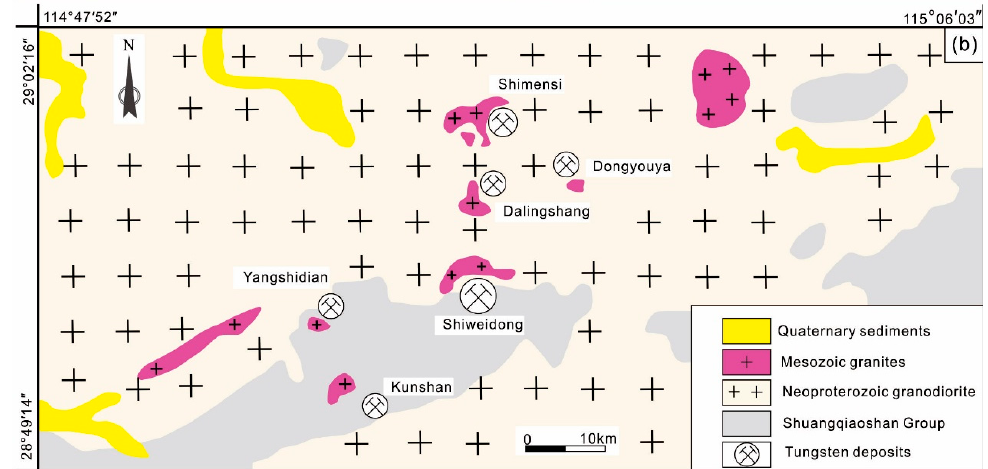
Figure 1. Geologic maps of the ( a ) Jiangnan Orogen (modified after Song et al. [4]); and ( b ) Shimensi W-Cu orefield (modified after Gong et al. [20]).